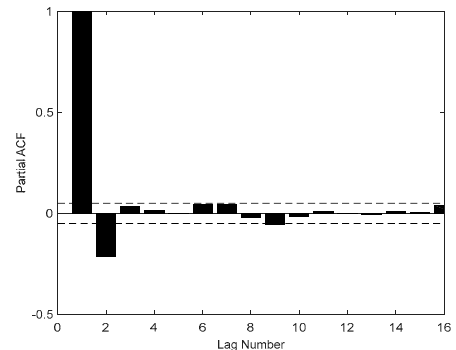
Figure 9. The partial autocorrelation function (PCAF) results of the EUA spot price after WT.